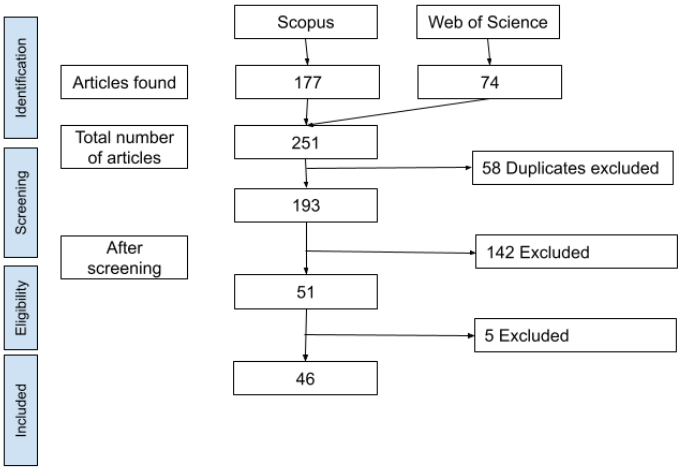
Figure 3. Flow diagram overview of consecutive stages and results at each